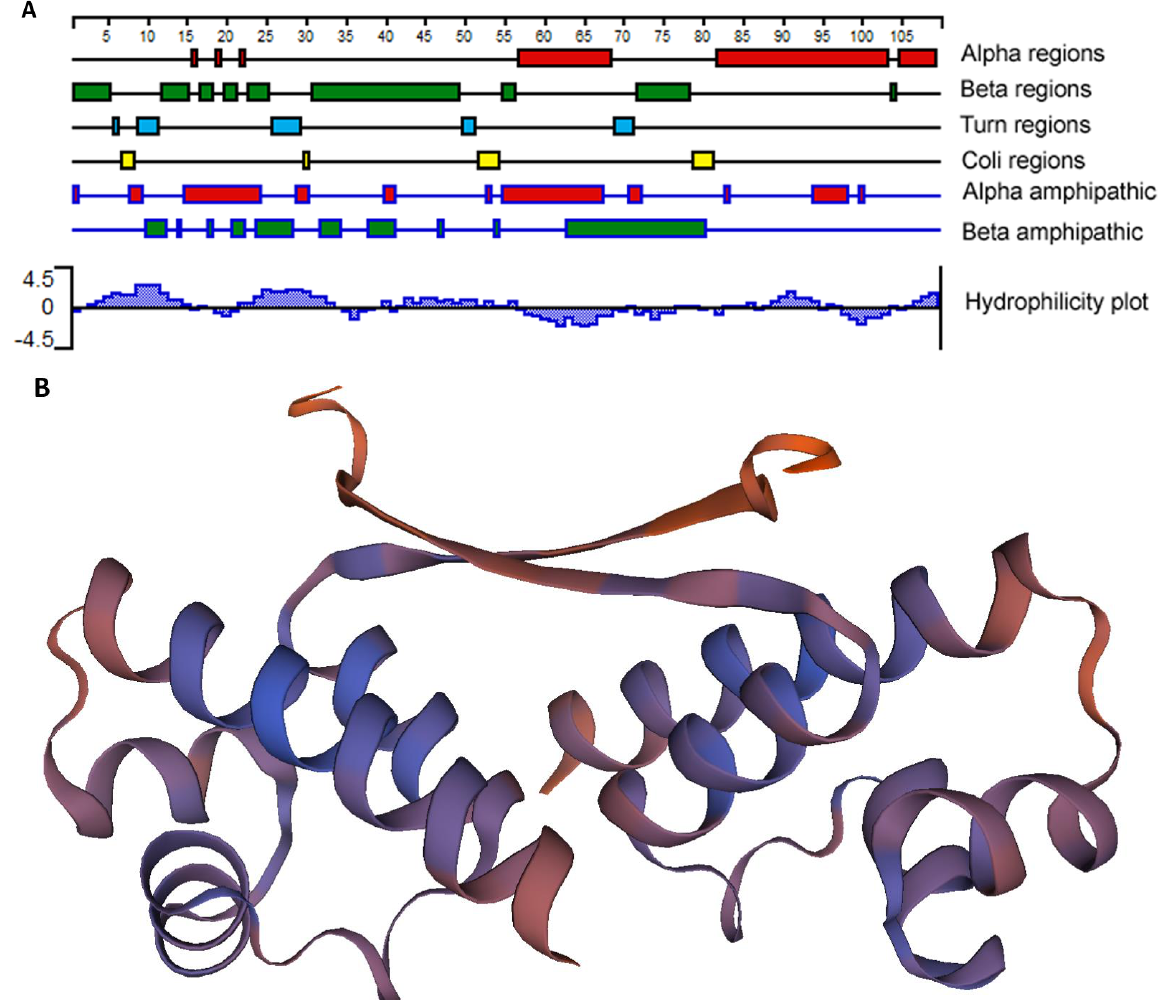
Figure 2. E. chaffeensis EcxR secondary structure and tertiary structure predictions. ( A ) The filled boxes with different colors indicate alpha regions (alpha helical), beta regions (beta strand), turn regions and coli regions, as identified using the Garnier-Osguthorpe-Robson algorithm. (The scale indicates 5-amino-acid intervals.) In the alpha amphipathic and beta amphipathic diagram, the filled boxes indicate regions that are predicted to form alpha helices and beta regions, respectively, and are comprised of amphipathic amino acids, as identified by the Eisenberg algorithm. The Kyte-Doolittle algorithm was used to identify hydrophobic (histogram above the x axis) and hydrophilic (histogram below the axis) regions described at the Hydrophobicity diagram. All of the analyses were carried out using Protean, as a part of the Lasergene software package. ( B ) Tertiary structure prediction of EcxR. EcxR forming as a homodimer was predicted by using SEWISS-MODEL algorithms.